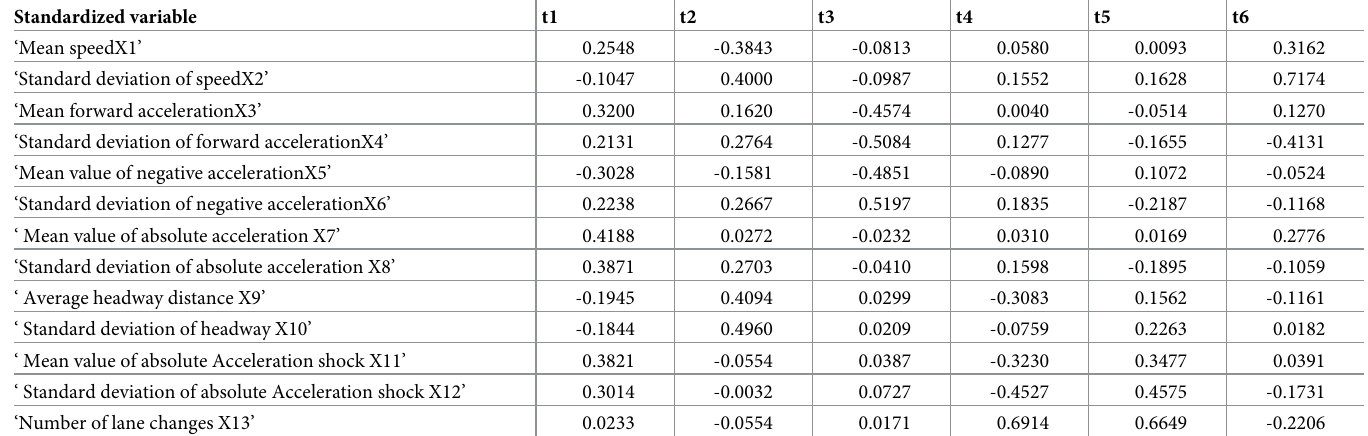
Table 3. Principal component score coefficient